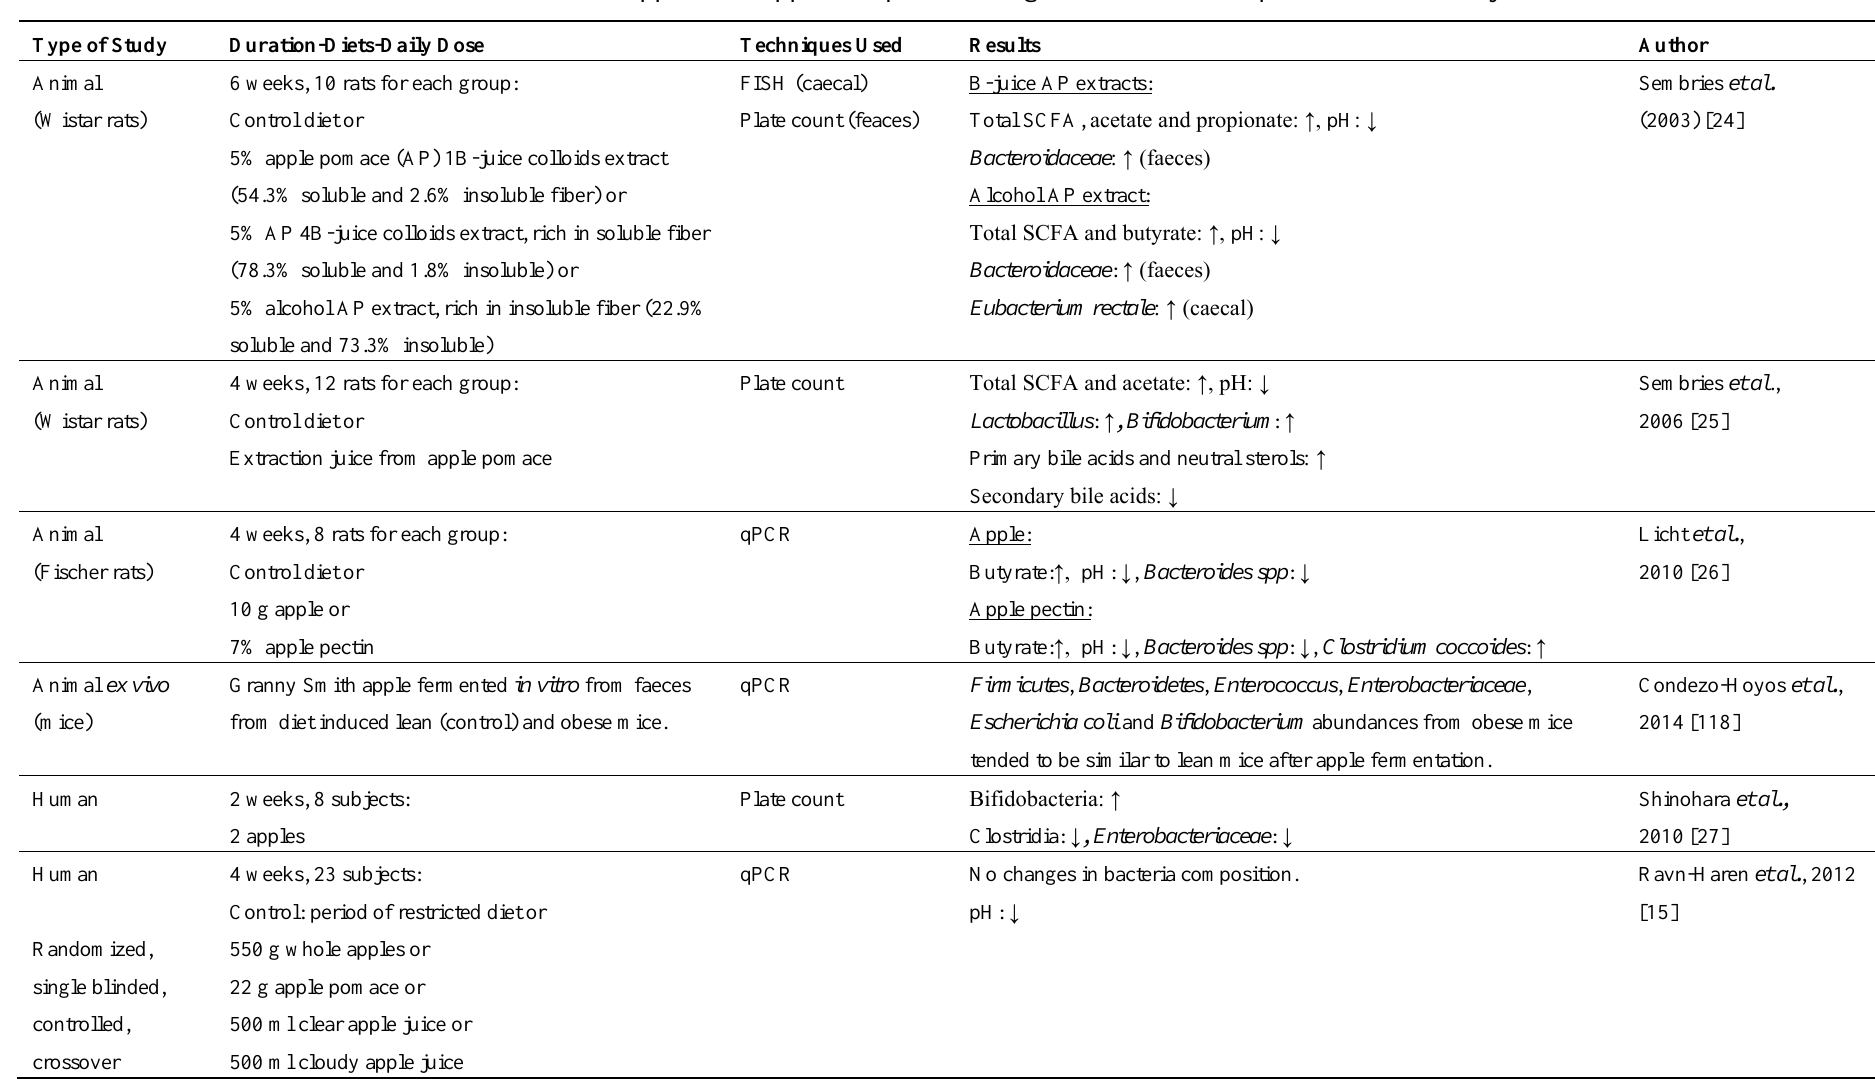
Table 2. Effects of apples and apple components on gut microbiota composition and